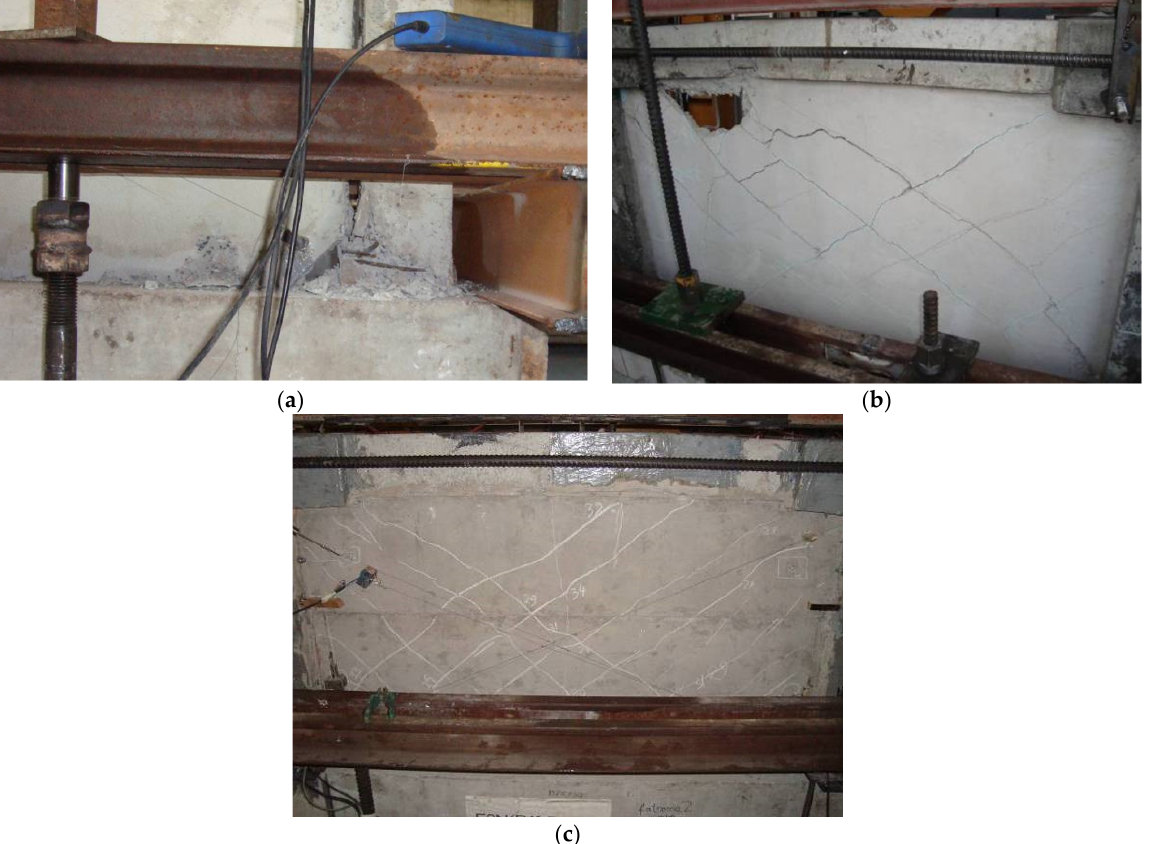
Figure 13. Damage of UC ‐ IP 1, UC ‐ IP 2, and RC ‐ IP 3. ( a ) Crushing of the UC infill panel and the RC frame at the corner. Specimen UC ‐ IP 1. ( b ) Large cracking of the UC infill panel. Specimen UC ‐ IP 2 ( c ) Control of cracking of the reinforced infilled panel. Specimen RC ‐ IP 3.